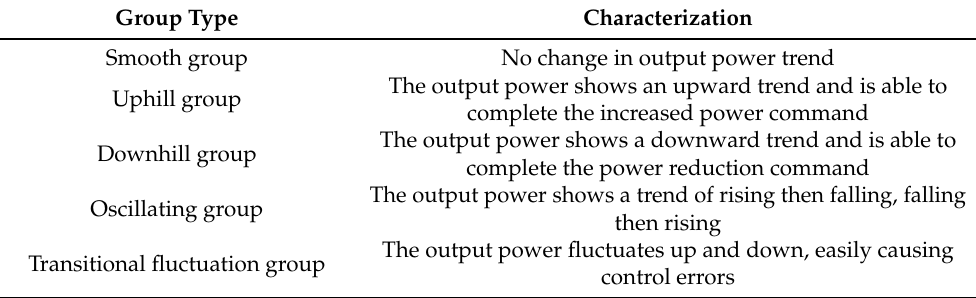
Figure 7. Process of wind farm dynamic clustering. ( a ) Smooth group; ( b ) Uphill group; ( c ) Downhill group; ( d ) First uphill then downhill group; ( e ) First downhill then uphill group; ( f ) Transitional fluctuation group. Table 2. Characterization of dynamic wind power